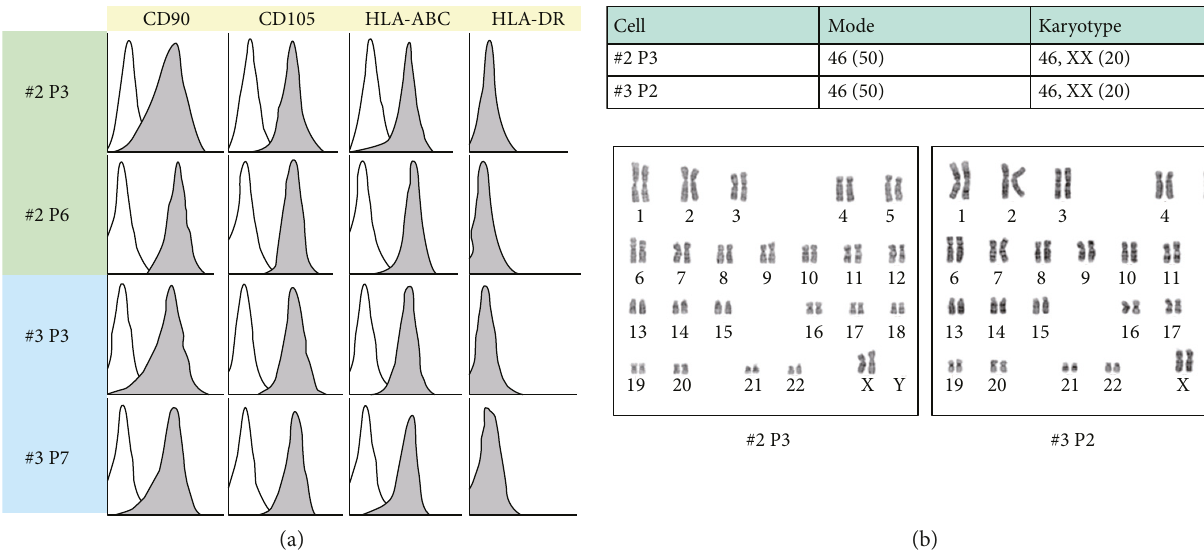
Figure 3: Flow cytometric analysis and karyotypic analysis. (a) Flow cytometric analysis of knst#2 (passages 3 and 6) and knst#3 (passages 3 and 7). (b) Karyotypic analysis of knst#2 (passage 3) and knst#3 (passage